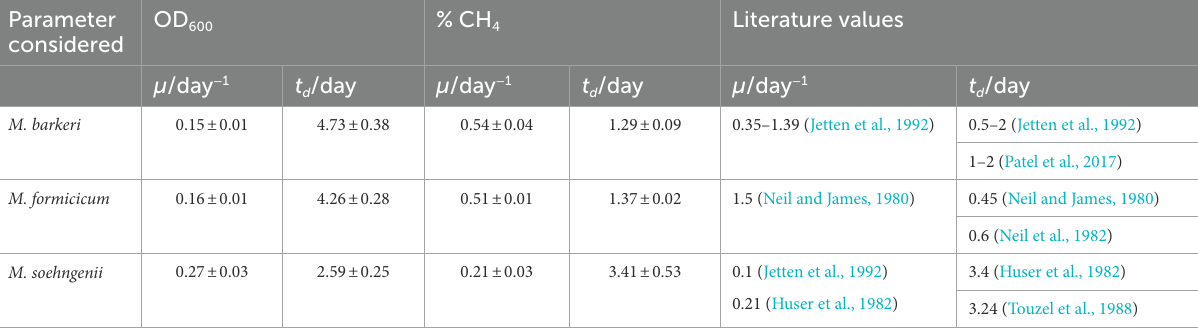
TABLE 4 Specific growth rate ( μ ) and doubling time ( t d ) of Methanosarcina barkeri, Methanobacterium formicicum and Methanothrix soehngenii as functions of OD 600 and CH 4 concentration in the headspace of the cultures. Parameter